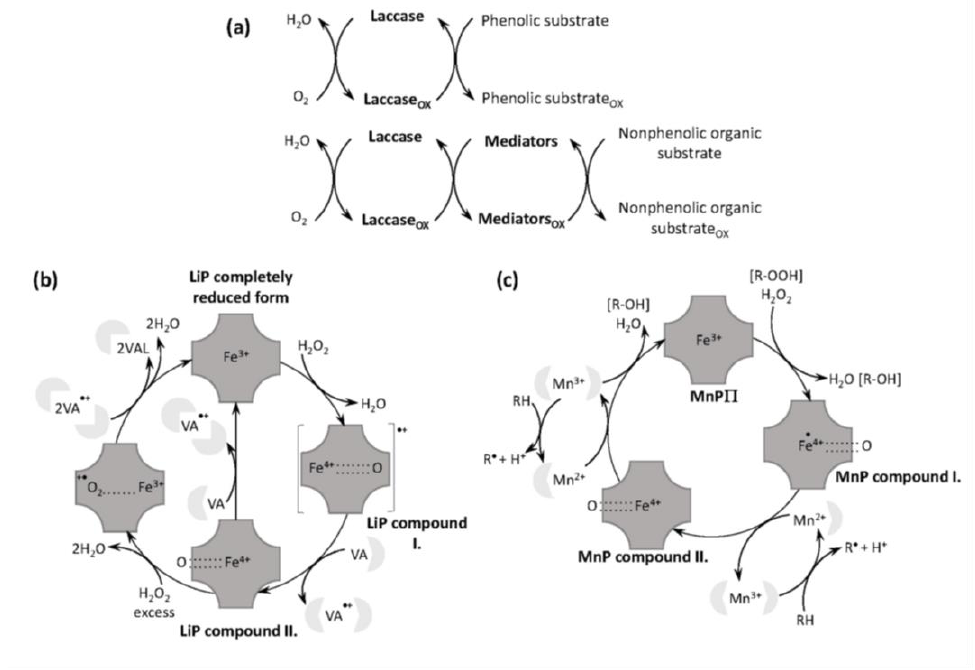
Figure 7. Biochemical activity of laccase ( a ), lignin peroxidase ( b ), and manganese peroxidase ( c ) (reproduced from [45], published under CCBY 4.0 license).